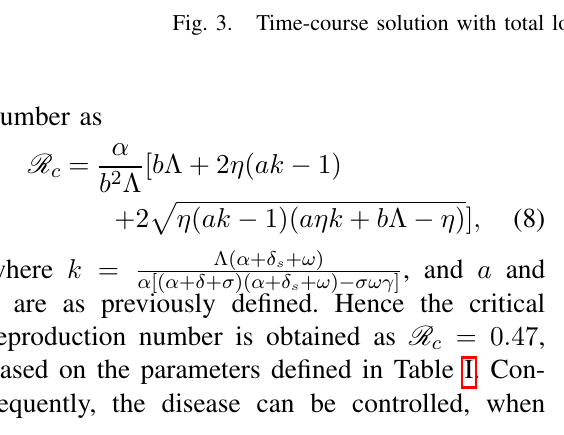
Fig. 3. Time-course solution with total lockdown and moderate isolation, η = 0 . 0